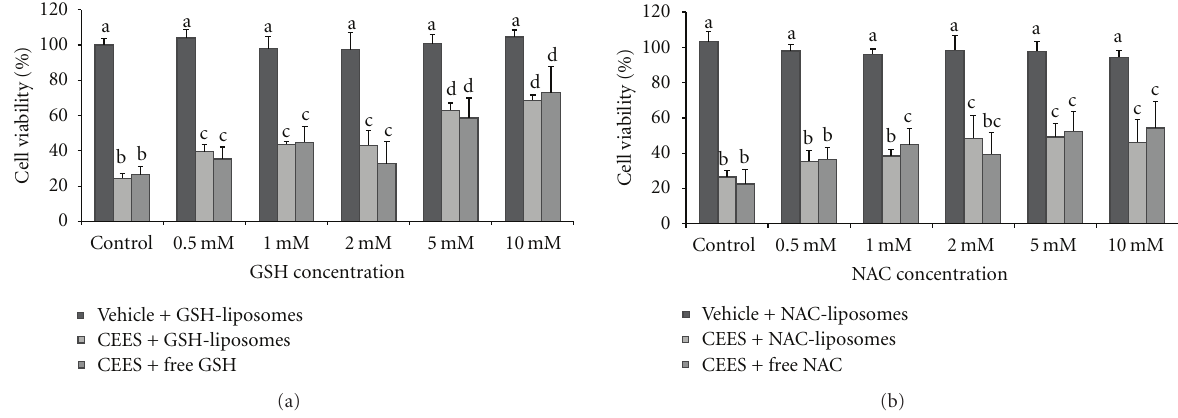
Figure 1: Protective e ff ects of “free” and liposome-encapsulated antioxidants in HaCaT cells . GSH (a) or NAC (b), either “free” (as stock solutions in PBS) or encapsulated in the phospholipid-based liposomes (calculated final concentration as indicated), were applied to HaCaT cells simultaneously with 1 mM CEES or vehicle (1% DMSO); blank liposomes (no antioxidant encapsulated) or PBS were used as controls for GSH- or NAC-liposomes and for “free” GSH or NAC, respectively. Cells were incubated at 37 ◦ C for 18 hours. Cell viability was measured using the MTS assay (see Section 2). Mean values not sharing a common letter are significantly di ff erent ( P < .